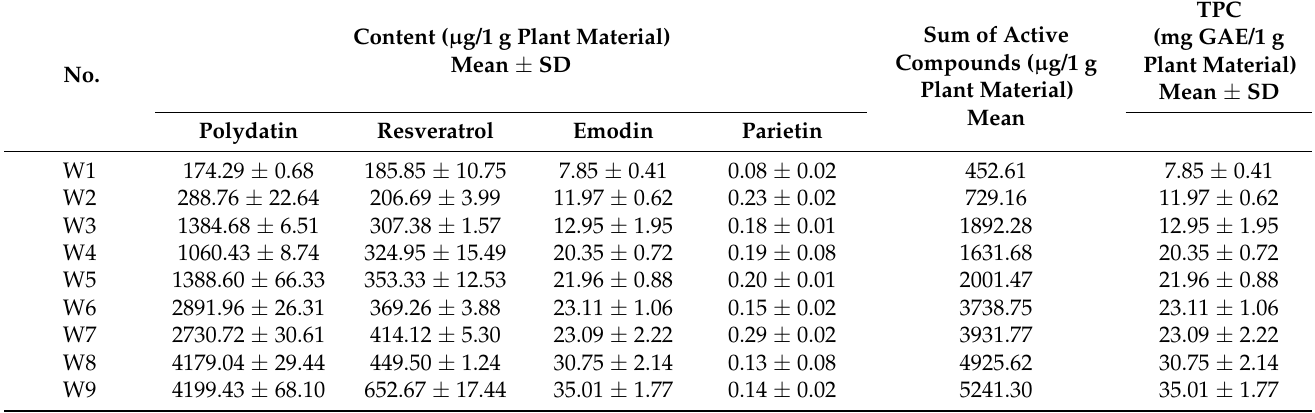
Table 3. Content of Active Compounds in the Extracts.